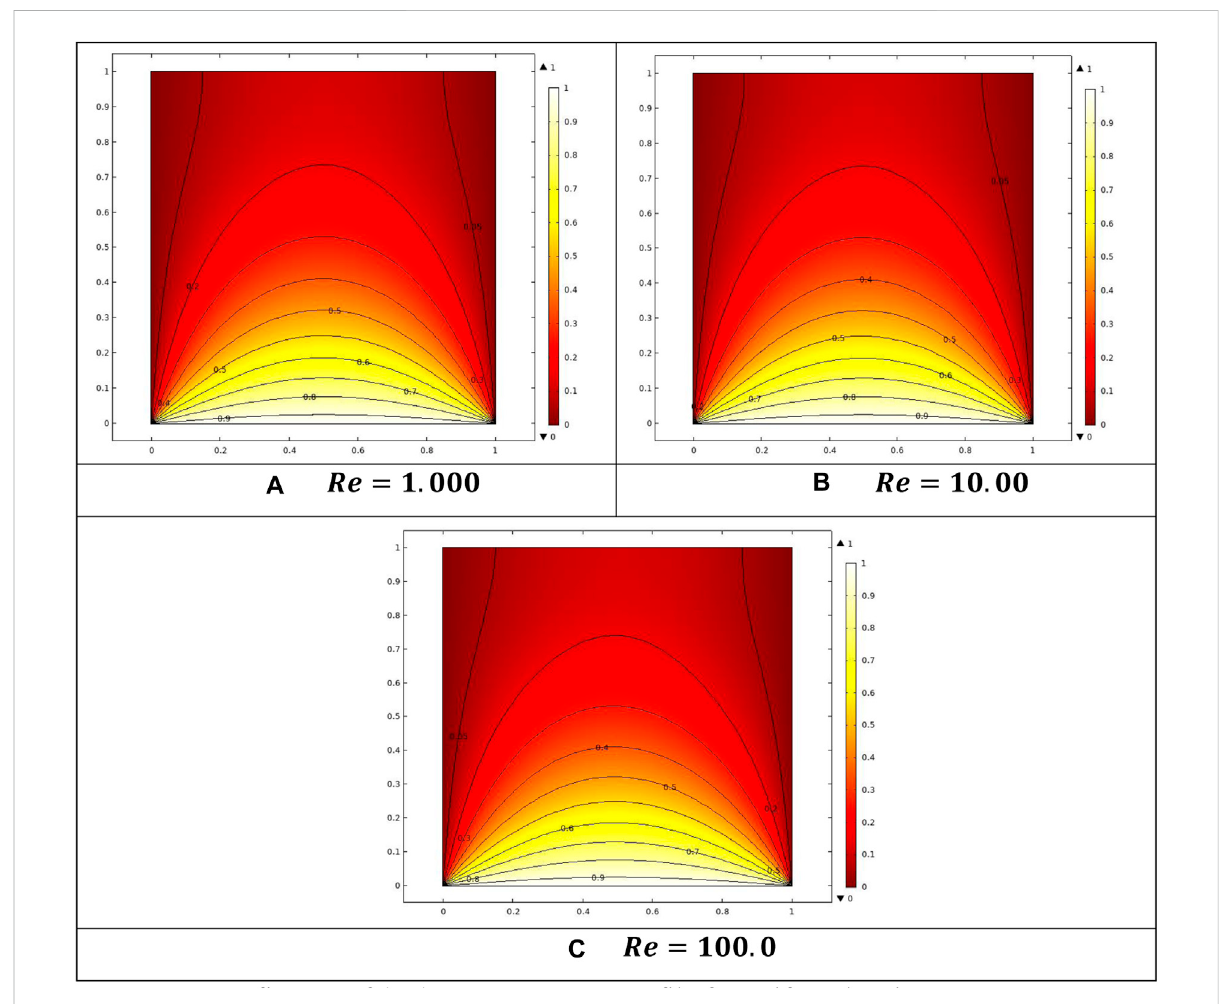
FIGURE 8 In fl uence of Re on the temperature pro fi le for the uniform heating case: (A) Re (cid:1) 1 . 000, (B) Re (cid:1) 10 . 00, and (C) Re (cid:1) 100 .